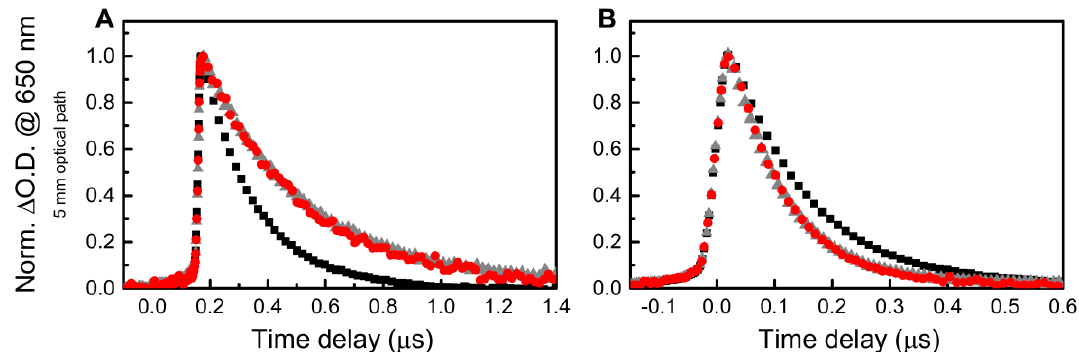
Figure 3. Kinetics of hydrated electrons within a microsecond time range after a 5 ps electron pulse in water (black squares), AuNPs suspensions containing 3 mM of gold atoms (red dots), and their supernatants (grey triangle). ( A ) AuNPs were prepared by the borohydride reduction method. AuNPs suspension, its supernatant, and water had pH 8. ( B ) AuNPs were prepared by the Turkevich method. AuNPs suspension and its supernatant had pH 5.4, and water had pH 6.